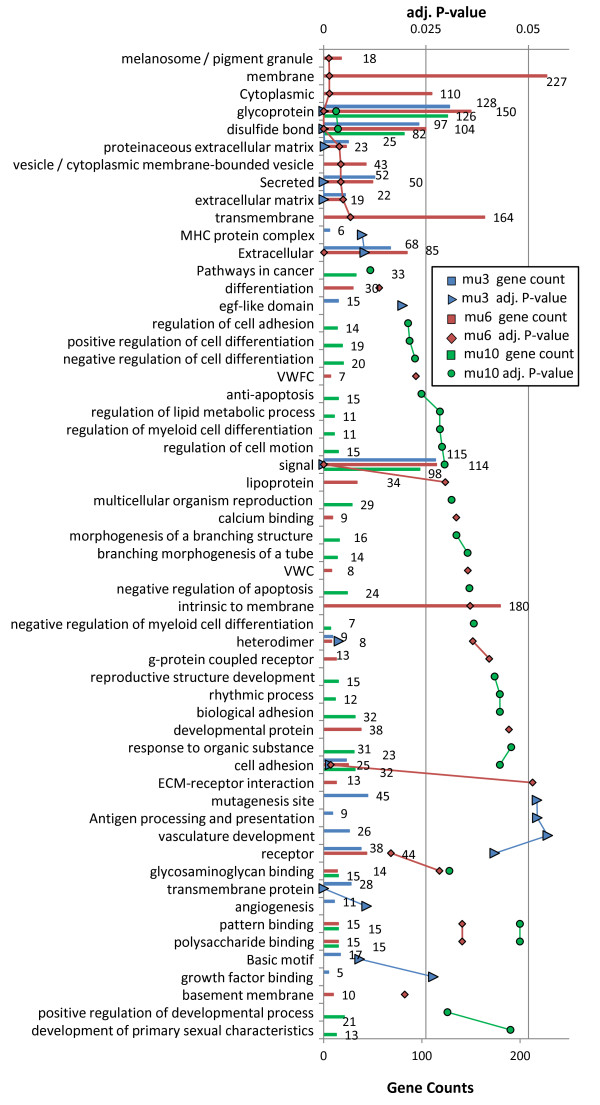
Functional groups significantly enriched among genes upregulated in Spalax muscle under acute and chronic hypoxia (mu3, mu6, mu10). Series names: muscle upregulation at 3% 6 hrs, 6% 6 hrs, 10% 44 hrs hypoxia, are denoted mu3 (blue), mu6 (red), mu10 (green), respectively. Line chart (triangles, diamonds, and circles) represents Benjamini adjusted P-value of term enrichment. Bars denote gene counts.